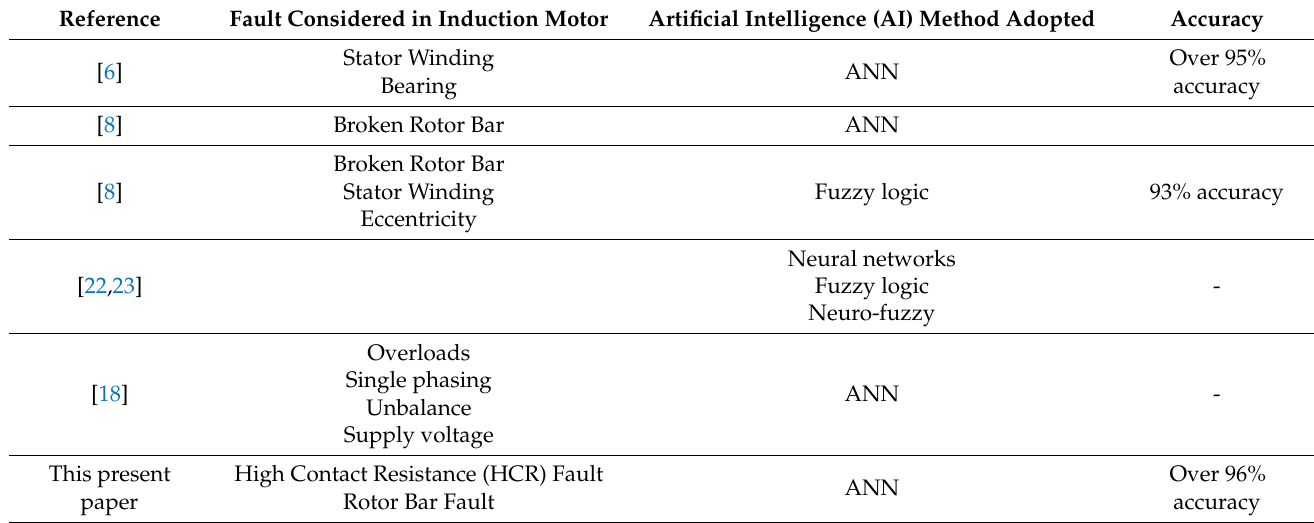
Table 1. Accuracy tabulated from the literature review versus a classification